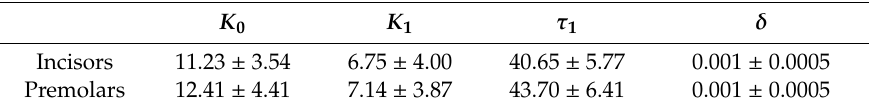
Table 1. Fitting parameters of the one-exponential function for temperature growth during polishing without water cooling, showing the average for all tested samples (n = 32).